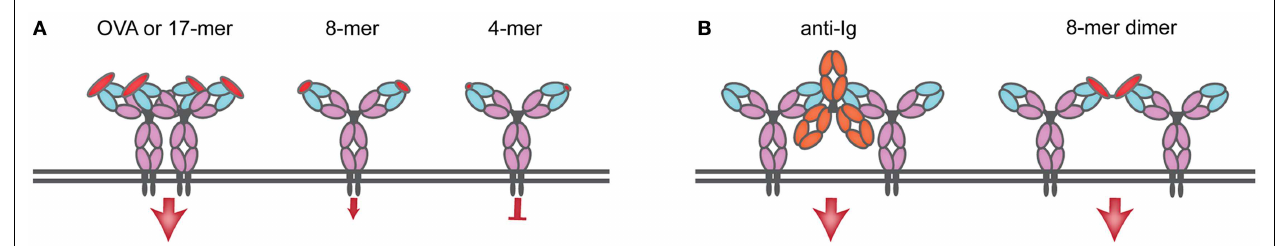
fails to produce above-threshold signals and it is suboptimal; a 4-mer peptide (GFGD) fails to induce any signal. (B) Reagents directed to the constant region of IgG (such as anti-IgG or anti-kappa) cross-link the BCR by bringing BCRs in close apposition, a similar effect is produced upon chemical conjugation of 8-mer to produce dimers that can now induce significant (above-threshold) BCR